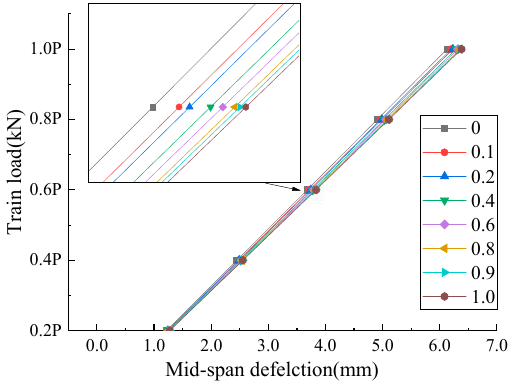
Figure 12. Rail deflection response under static and fatigue load.